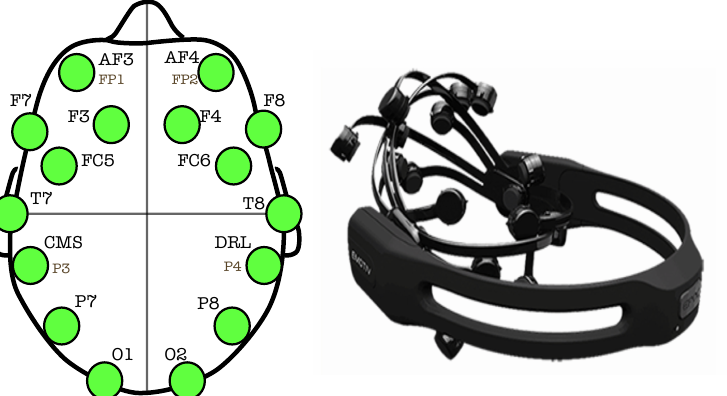
Figure 1. Electrode location ( left side ) of the Epoc+ headset ( right side ) of the Emotiv Inc., taken from Emotiv website https://emotiv.gitbook.io/epoc-user-manual/, accessed on 29 December